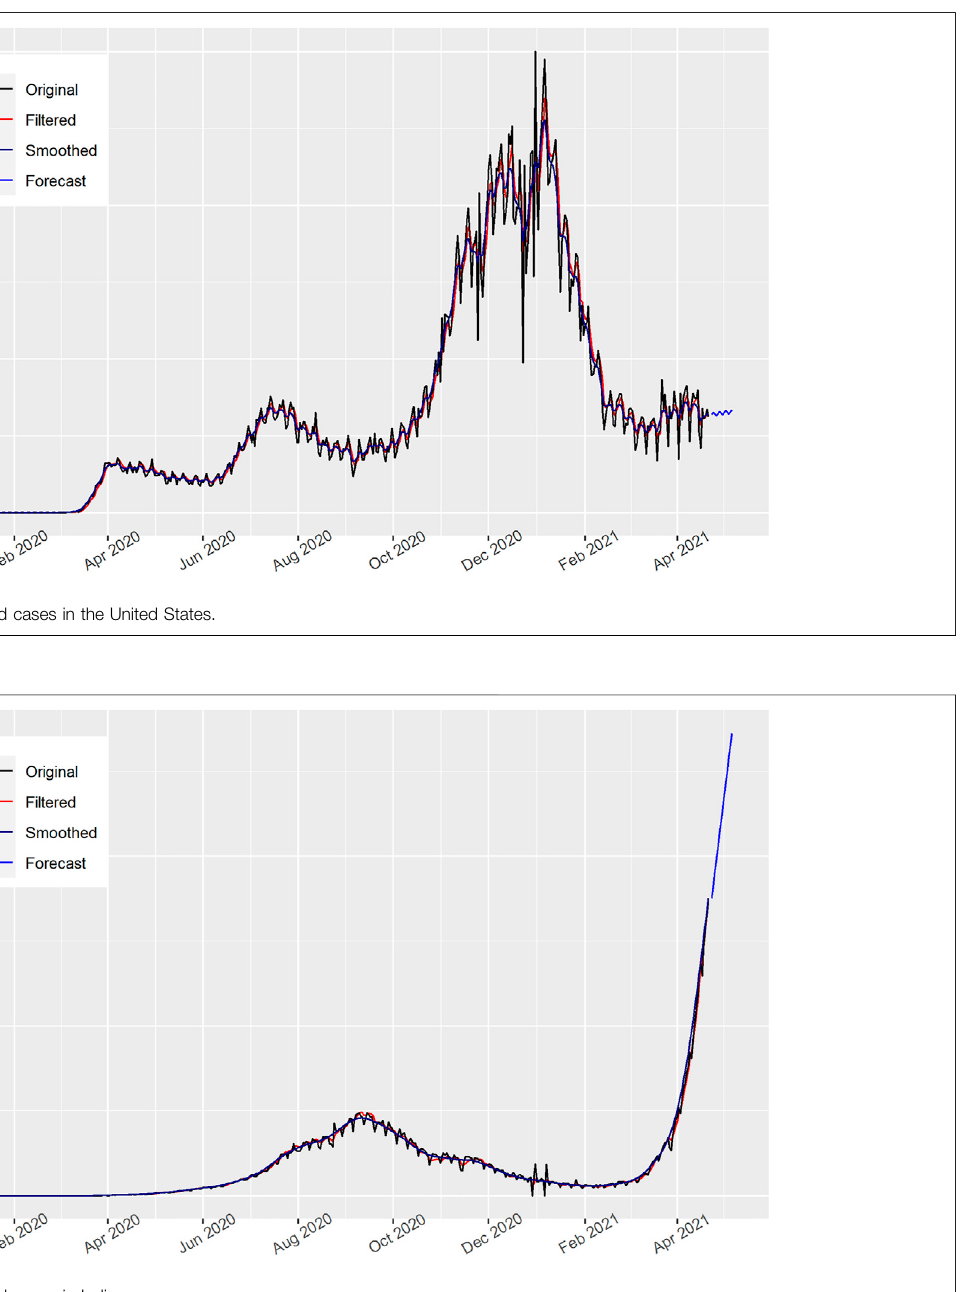
FIGURE 2 | Number of daily Con fi rmed cases in